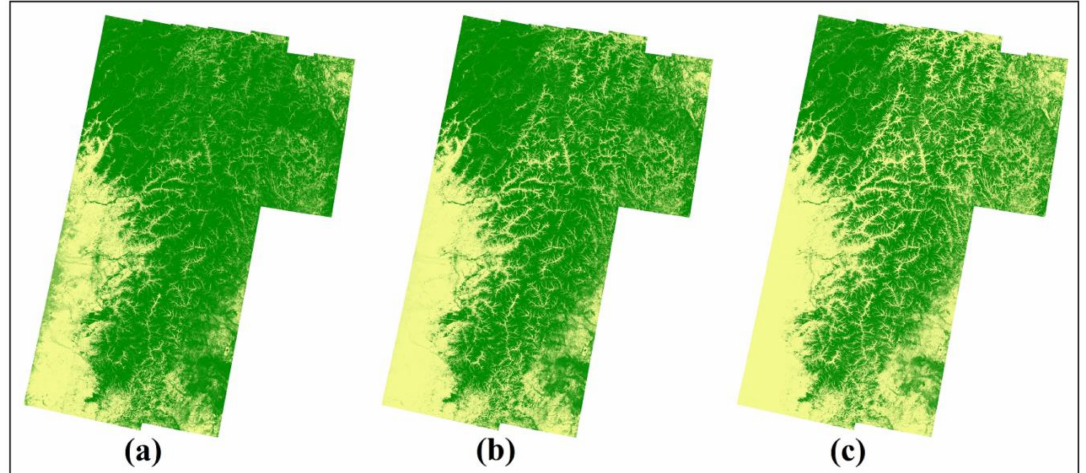
Figure 12. Forest maps produced by di ff erent thresholds of canopy coverage estimated by the model_2015: ( a ) > 10%; ( b ) > 20%; ( c ) > 30%. Green: forest, Yellow: